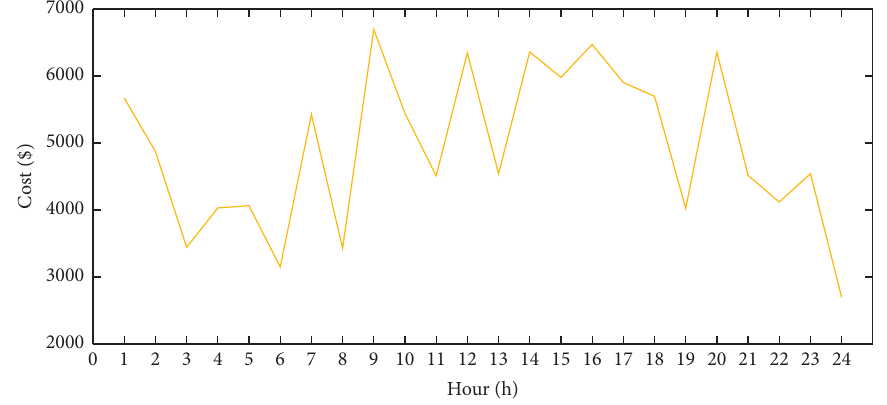
Figure 20: Daily cost in spring/autumn.